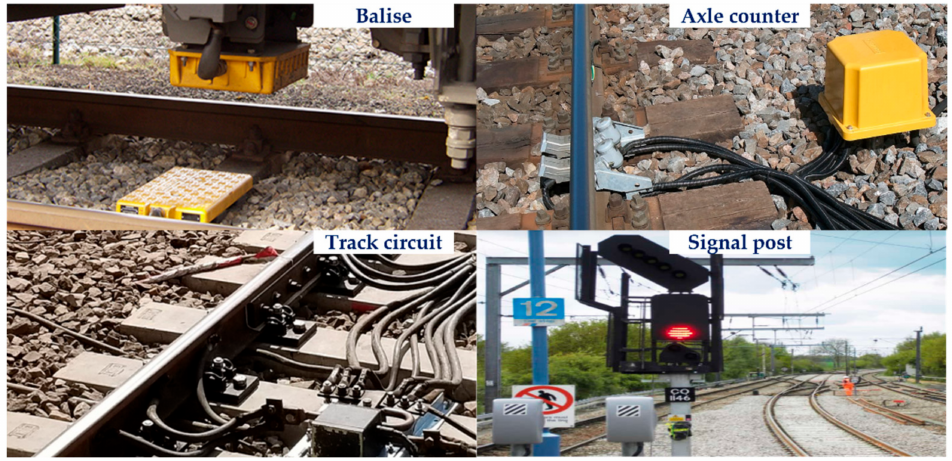
Figure 4. Track-side infrastructures.